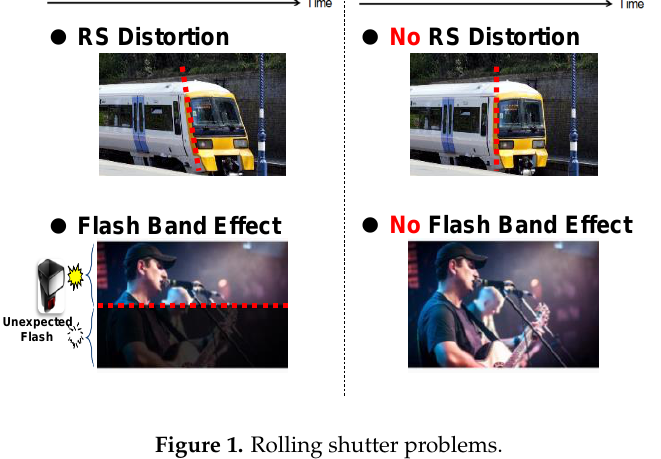
Figure 1. Rolling shutter problems.